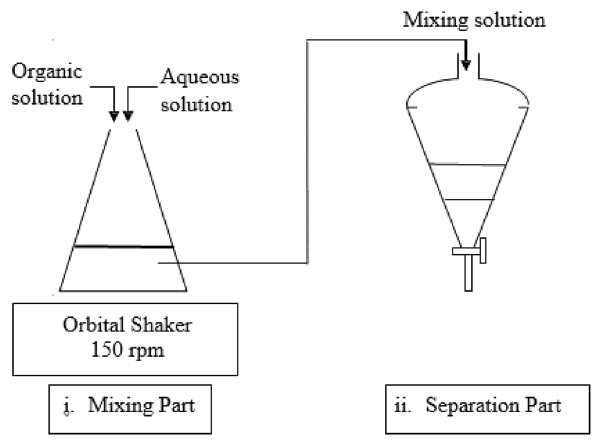
Fig. 3 Schematic layout of LLE